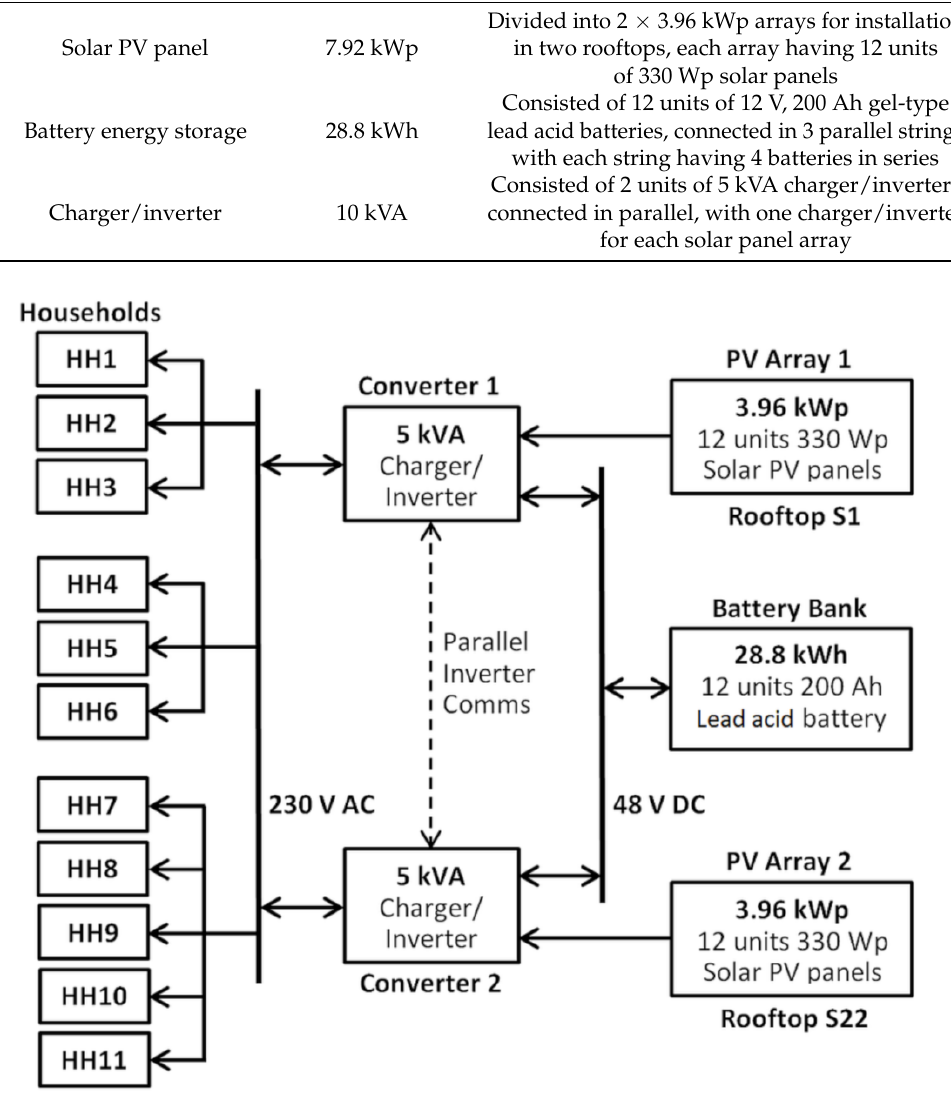
Figure 13. Gilutongan Island solar microgrid single line